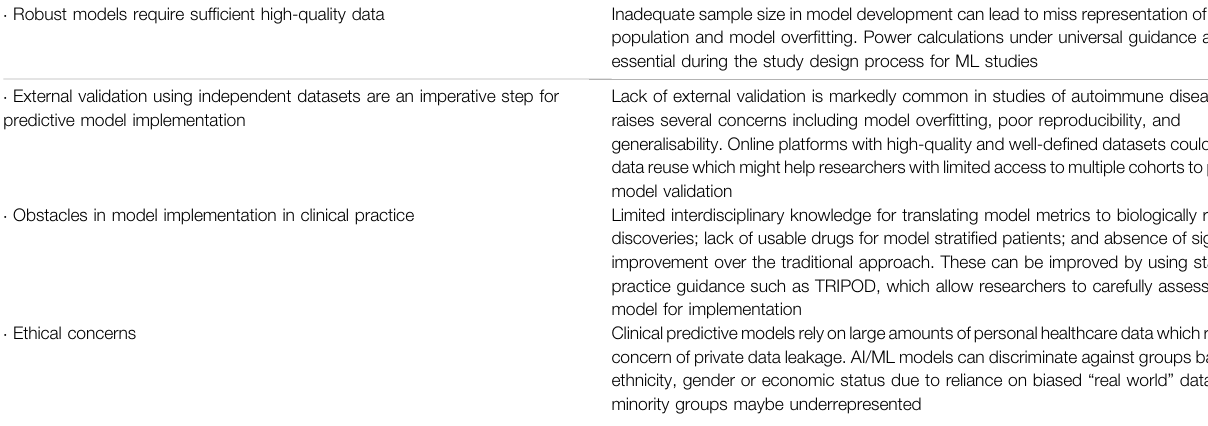
TABLE 3 | Challenges in applying machine learning techniques in precision medicine for immune-mediated chronic in fl ammatory diseases. · Robust models require suf fi cient high-quality